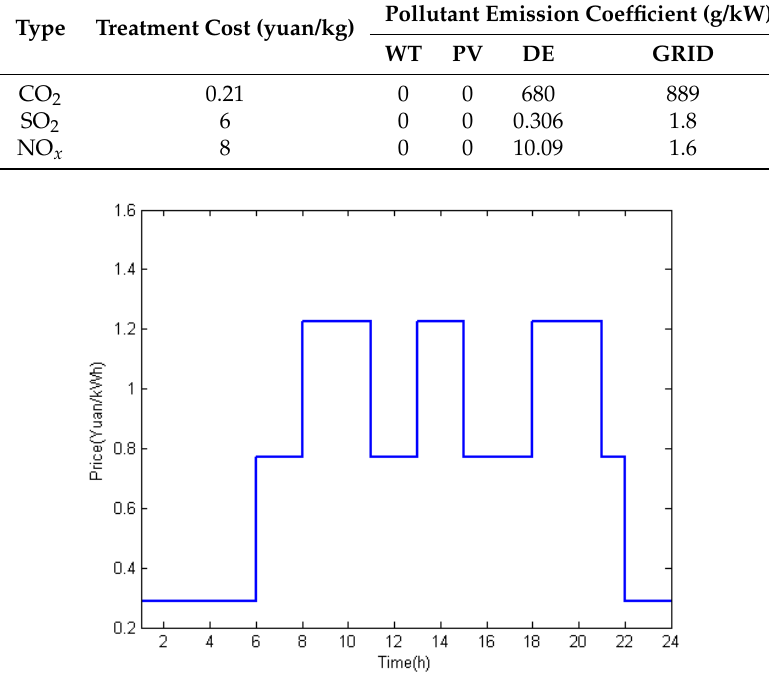
Table 3. Environmental parameters.